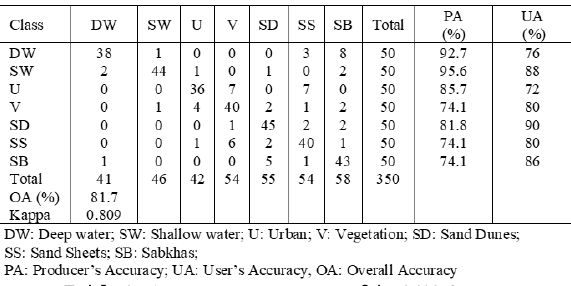
Table 4. Accuracy assessment of the LULC